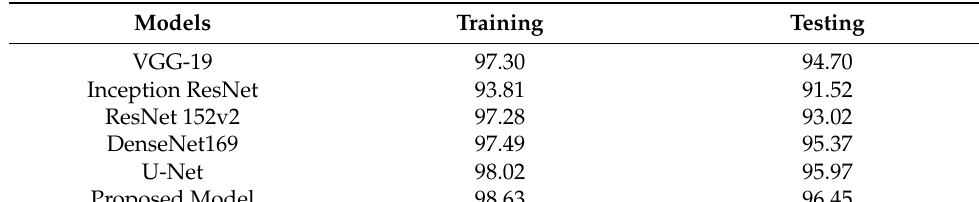
Figure 8. Comparative analysis of the testing and training accuracy of the proposed model with traditional models.